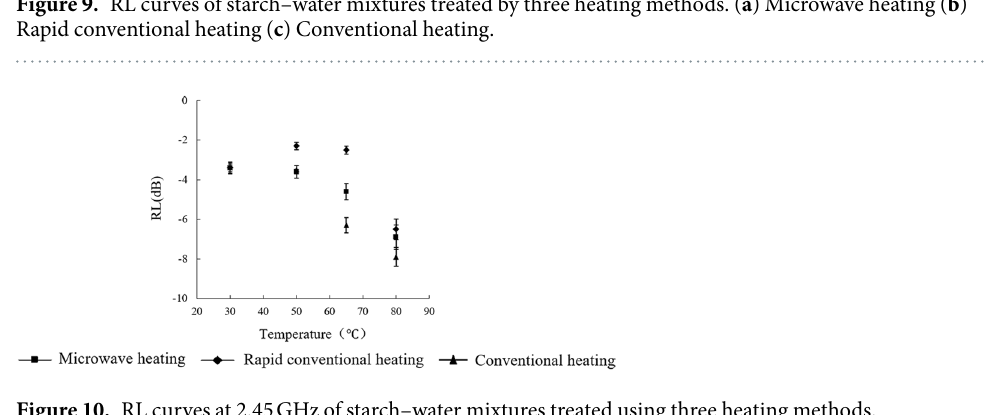
Figure 10. RL curves at 2.45 GHz of starch–water mixtures treated using three heating